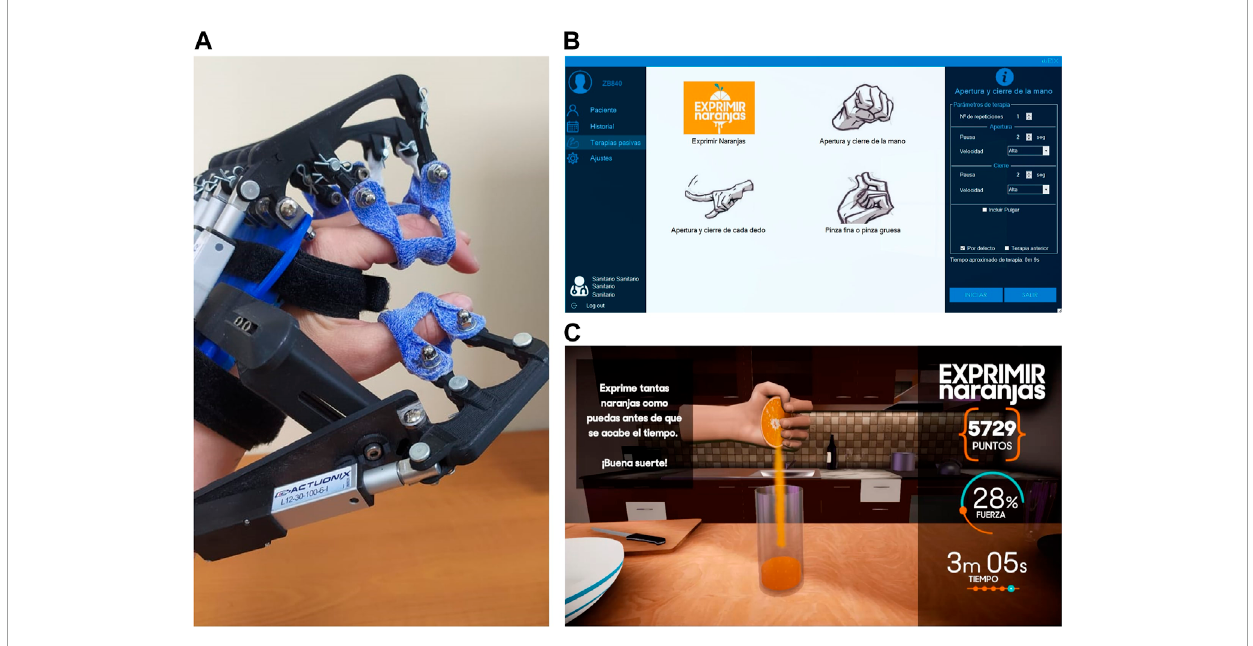
FIGURE 2 RobHand rehabilitation platform. (A) RobHand exoskeleton (B) Tab for selection and configuration therapies (C) Squeeze oranges